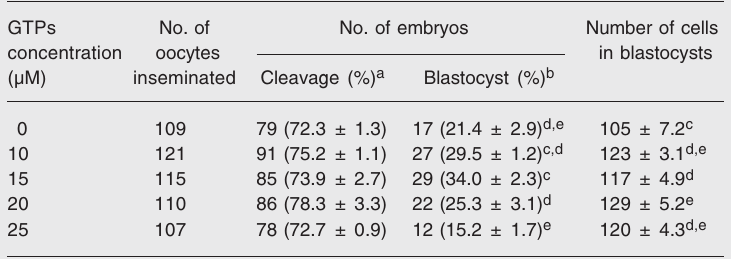
a Number of embryos is reported as median and percent of embryos cleaved